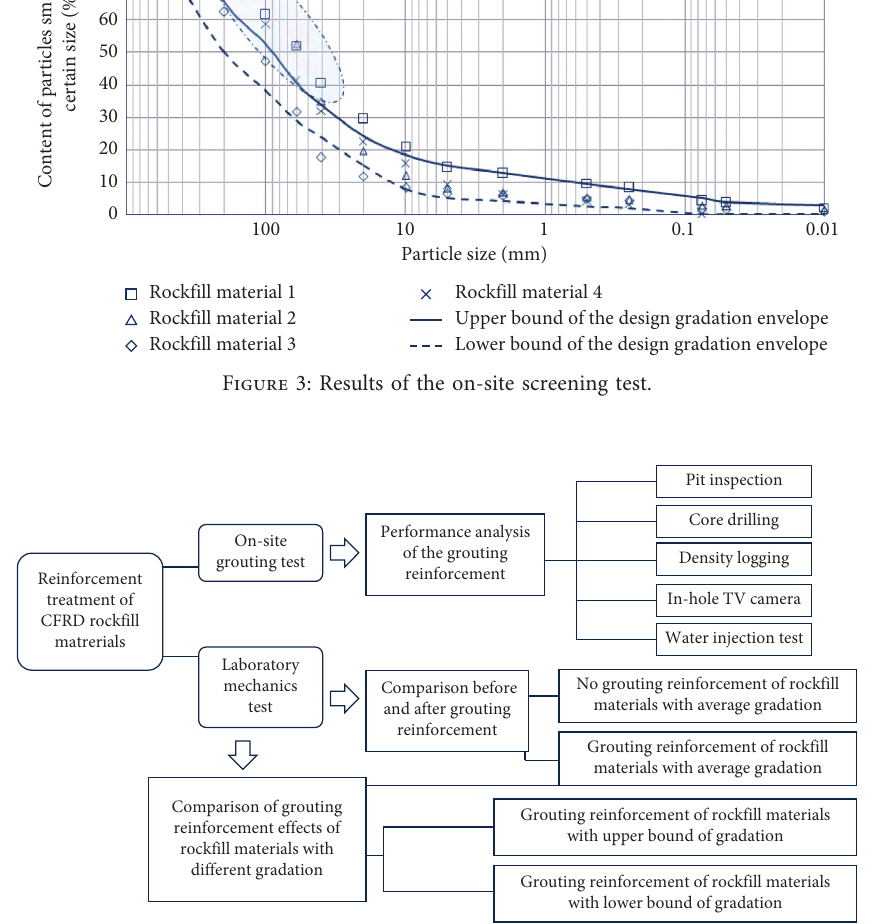
Figure 4: Test scheme of the grouting reinforcement treatment for CFRD rockfill materials.